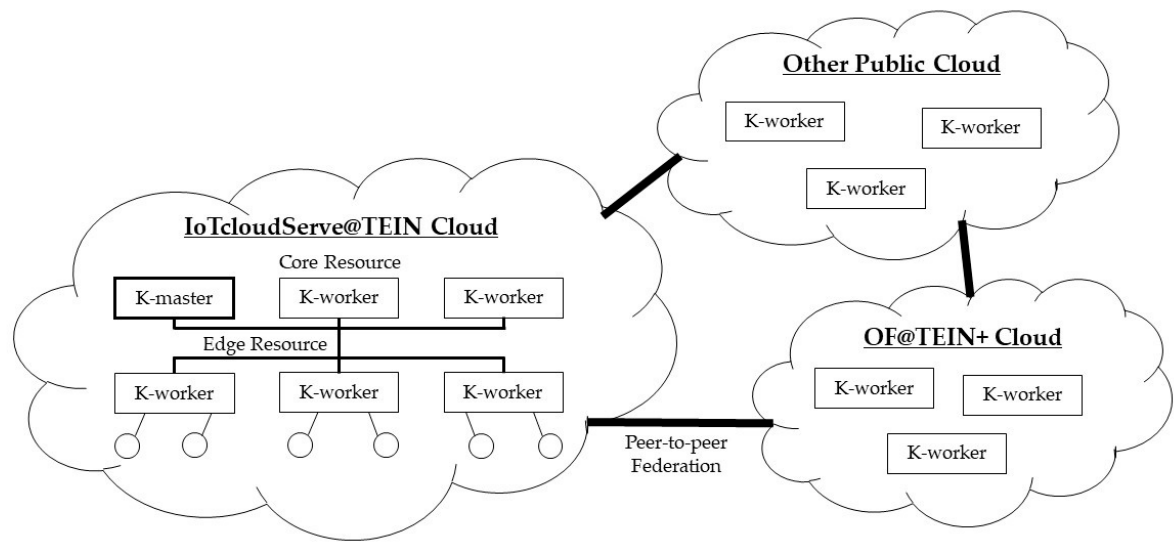
Figure 1. Overall conceptual structure of IoTcloudServe@TEIN edge-core cluster and cloud federation with